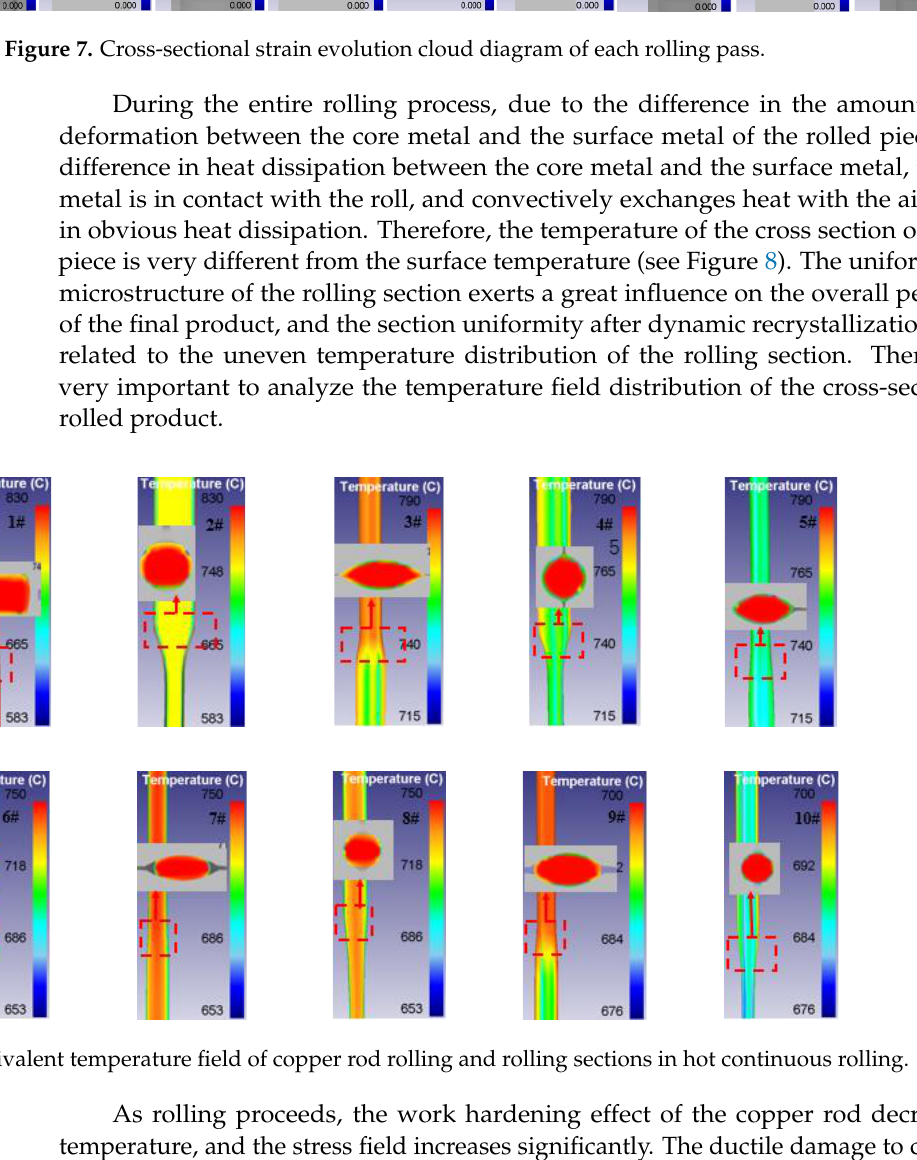
Figure 9. Damage program of hot continuous rolling copper rod and rolling section.